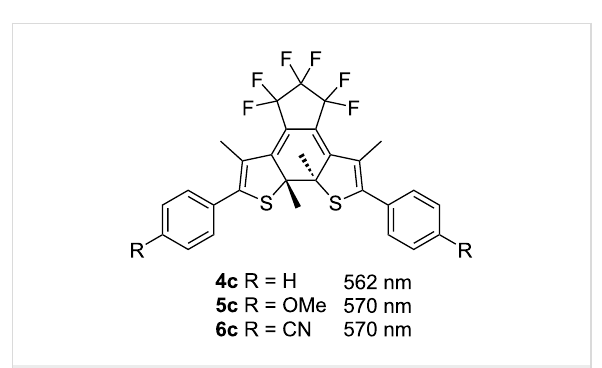
Table 2: Absorption spectral data of triazoles and other related photo- chromic compounds.